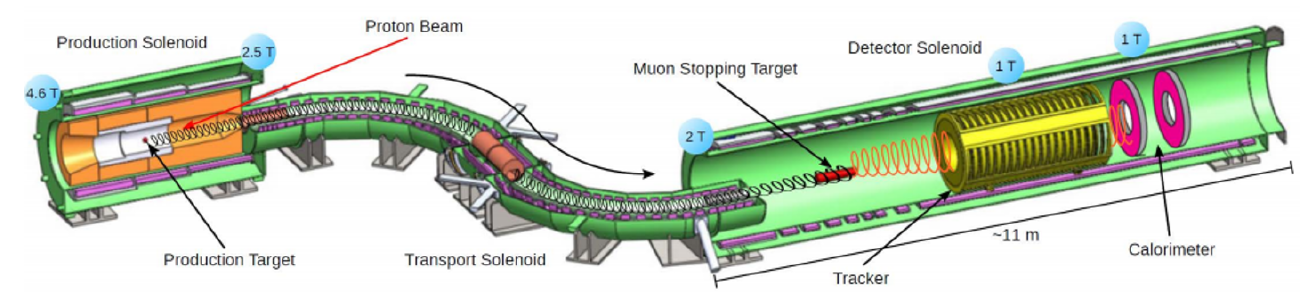
Figure 1. Layout of the Mu2e experiment: PS, DS, and TS solenoids are indicated in the picture. The cosmic ray veto, surrounding the DS and part of the TS solenoids, is not